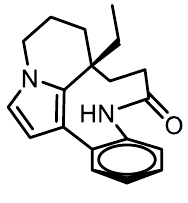
Figure 4. Antimitotic alkaloid (-)-rhazinilam ( 1 ).